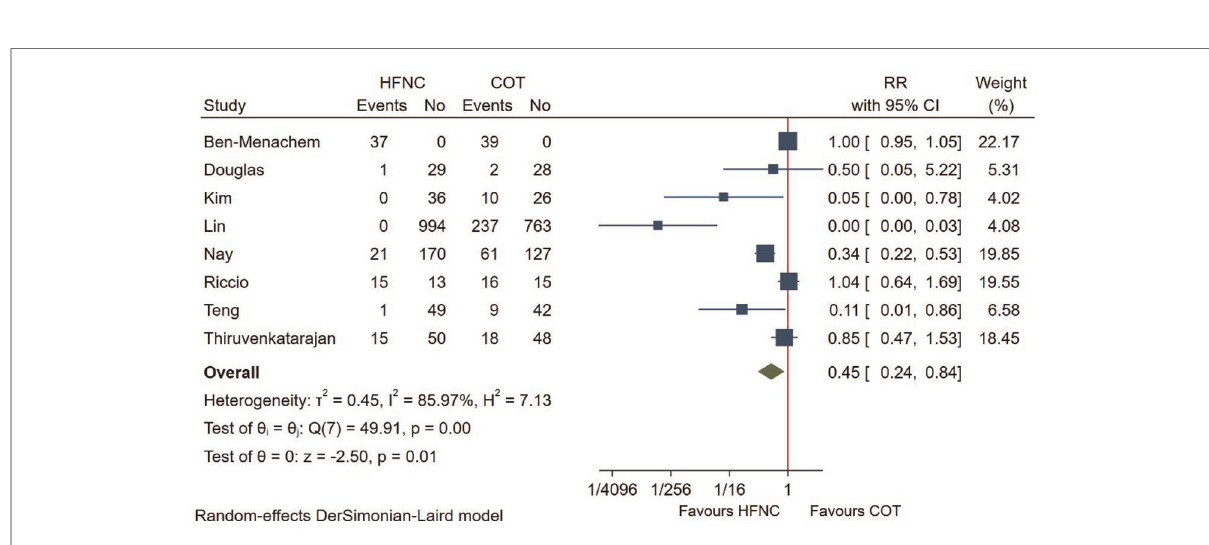
FIGURE 5 Forest plot comparing airway intervention during the procedure in HFNC versus COT. HFNC, high fl ow nasal cannula; COT, conventional oxygen therapy; RR, risk